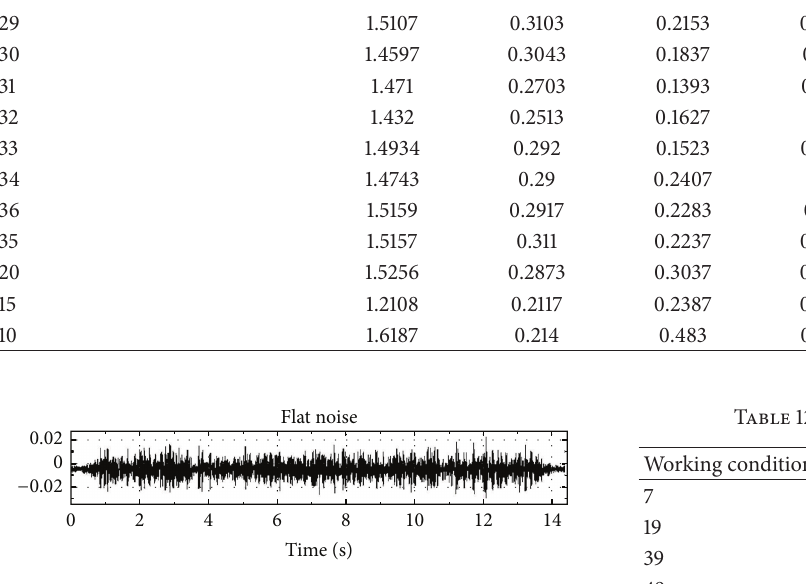
Figure 13: White noise signal of vibration table setting.